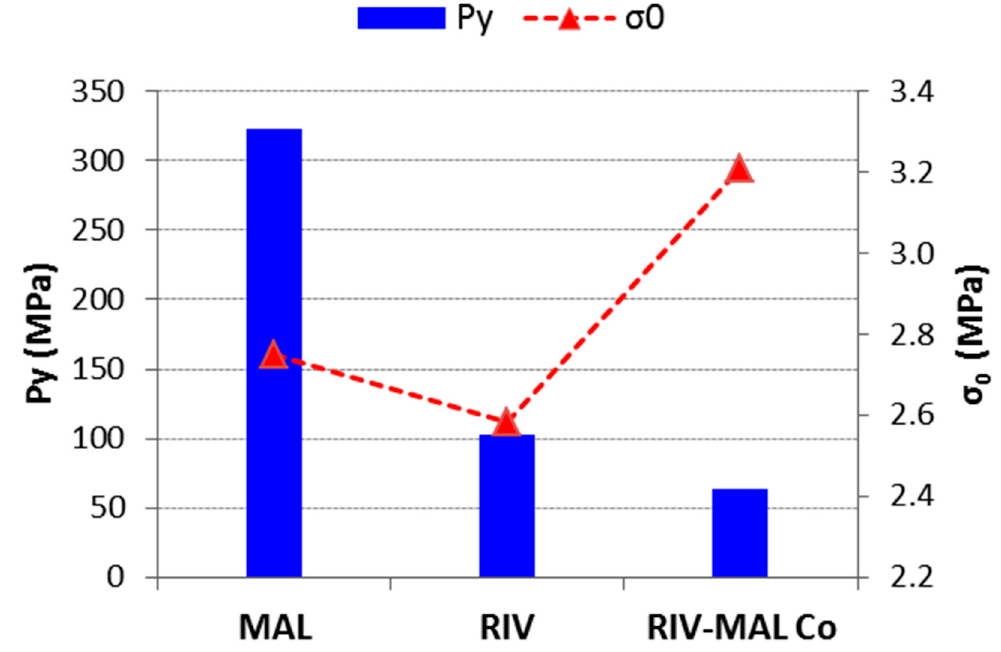
Figure 5. A plot of mean yield pressure (Py) and tensile strength at zero porosity ( σ 0 ) for RIV, MAL, and RIV-MAL Co.